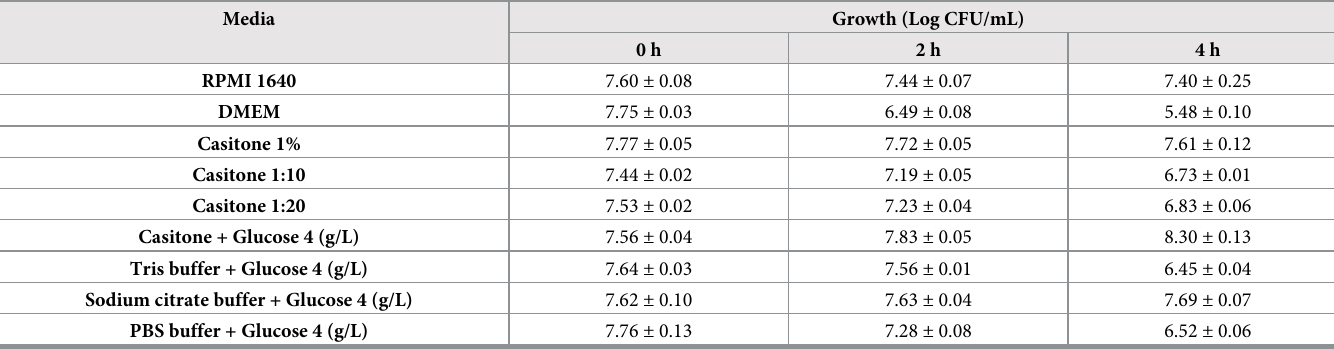
Table 3. Viability of L . reuteri CRL1098 in different media after 4h at 37 ˚C under agitating condition. Media